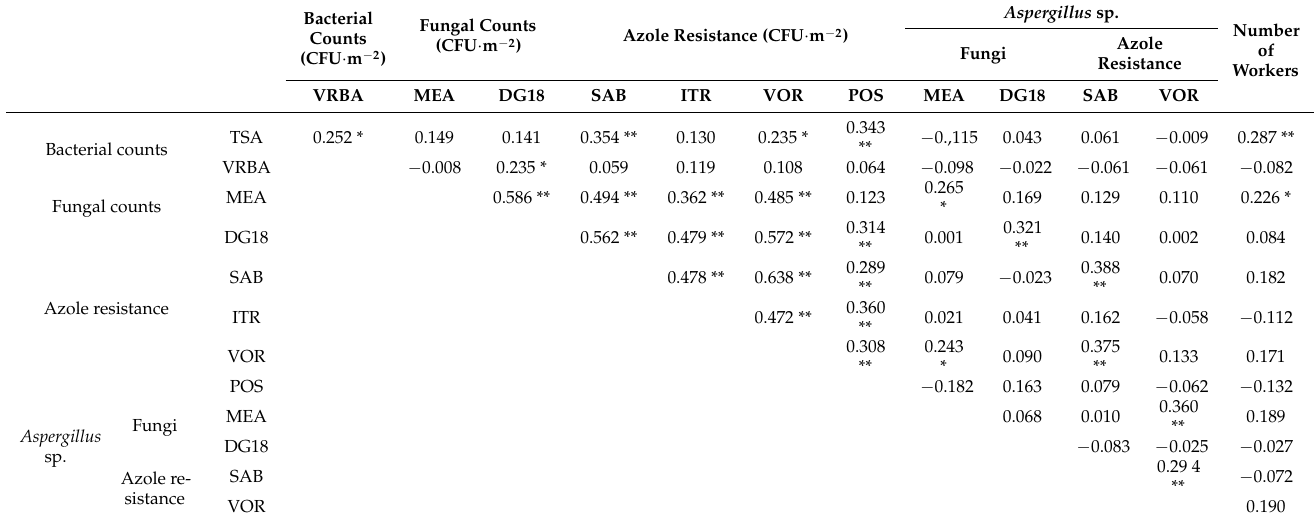
Table 5. Study of the relationship between bacterial and fungal counts, azole resistance (SAB, ITR, VOR and POS) and Aspergillus sections (MEA, DG18) and azole resistance screening (SAB, VOR). Spearman correlation coefficient results. Bacterial